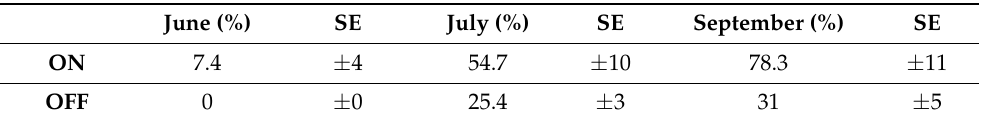
Table 1. Bud drops percentage during the season in bearing and non-bearing pistachio branches (SE = standard